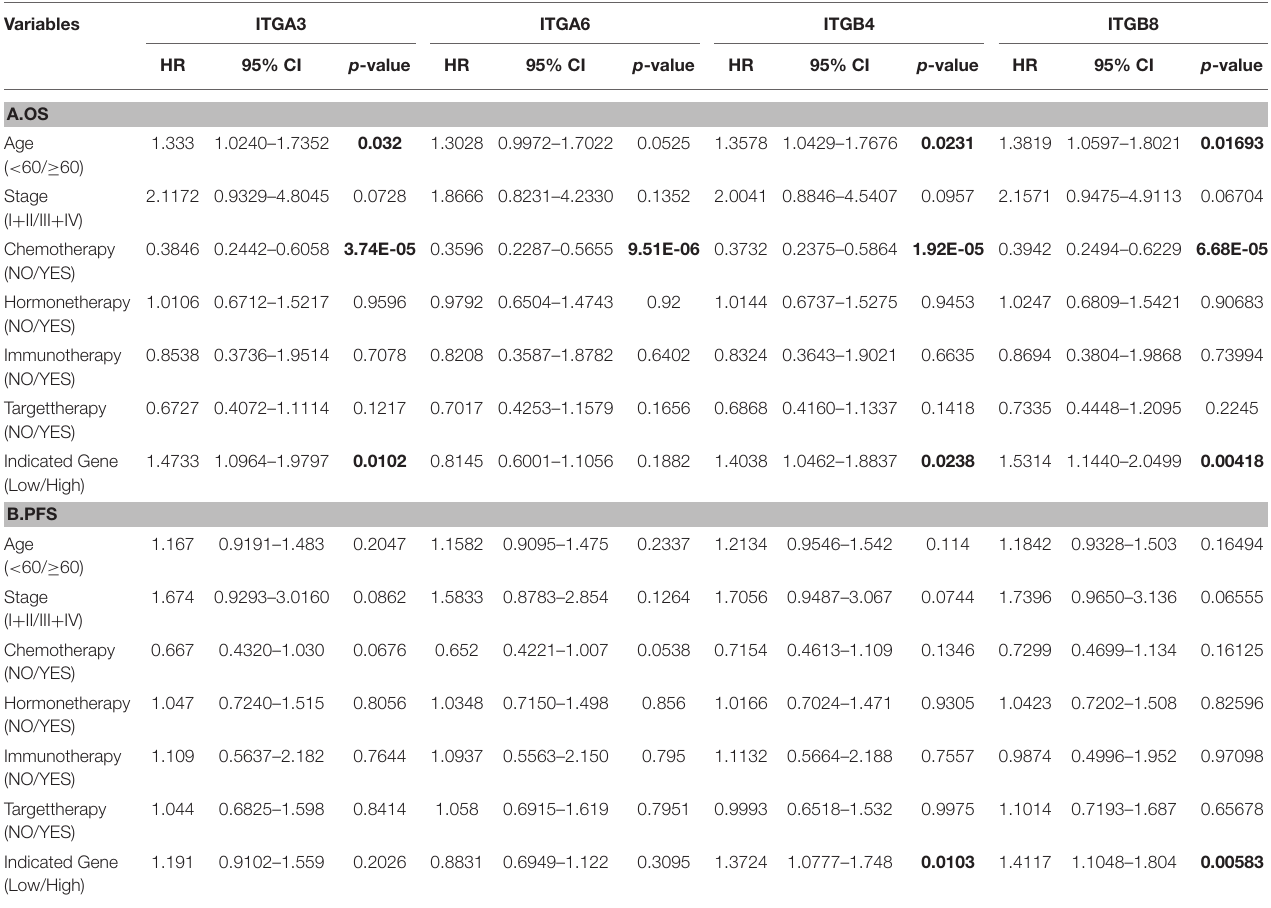
TABLE 5 | Multivariant Cox regression analysis of OS and PFS in OC